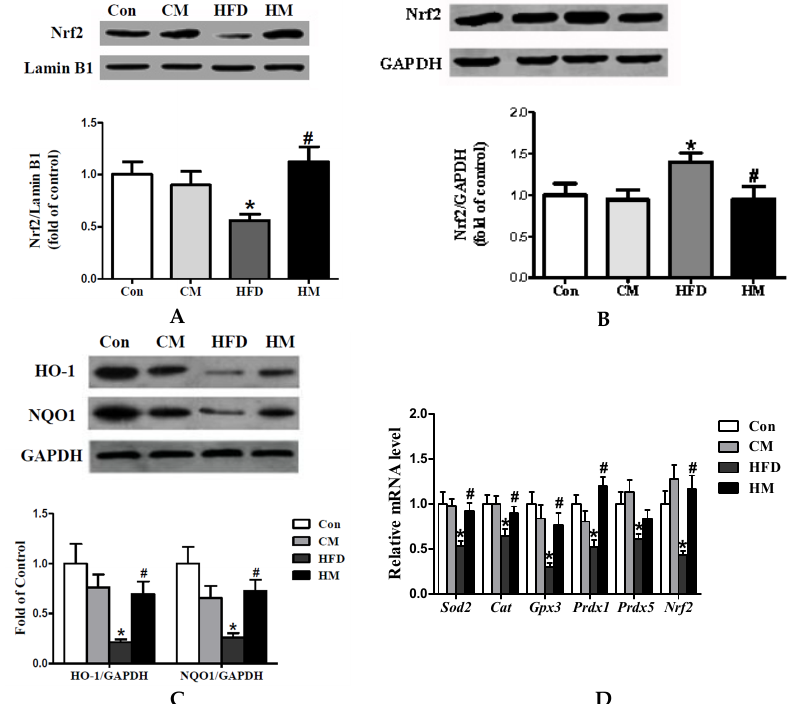
Figure 6. Myricetin activated the hepatic Nrf2 pathway and normalized expressions of genes involved in oxidative stress. ( A ) Protein expression of hepatic nuclear Nrf2; ( B ) protein expression of hepatic cytosolic Nrf2; ( C ) protein expression of hepatic NQO1 and HO ‐ 1; and ( D ) relative expression of genes involved in oxidative stress. Values were presented as mean ± SEM ( n = 8). Con, control diet; CM, control diet with additional 0.12% myricetin; HFD, high ‐ fat diet; HM, high ‐ fat diet with additional 0.12% myricetin. * p < 0.05 vs. the Con group; # p < 0.05 vs. the HFD group.